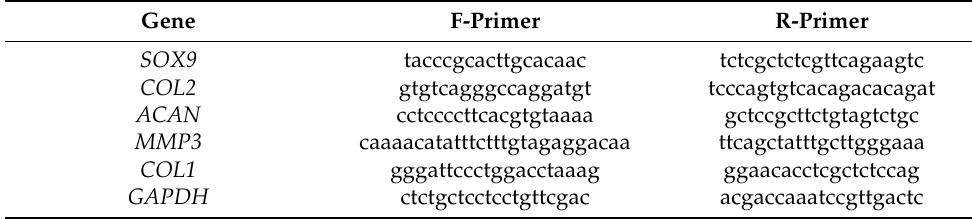
Table 1. Table of